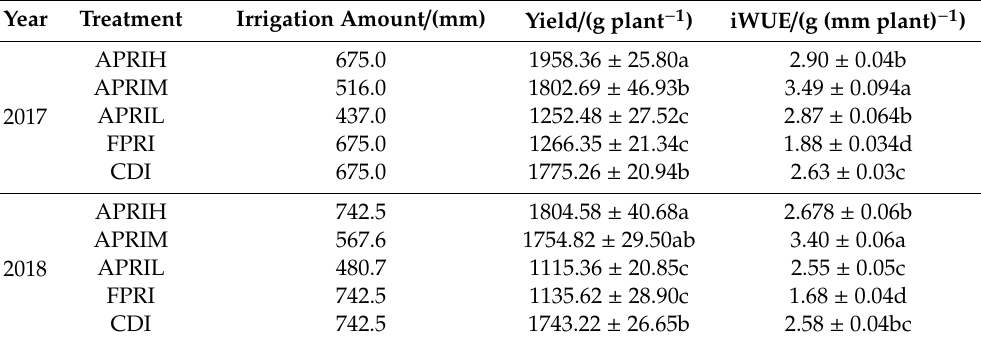
Table 5. Yield and iWUE under di ff erent irrigation